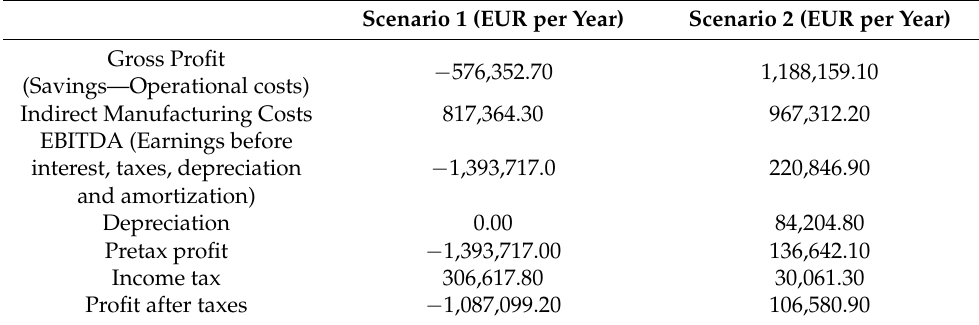
Table 8. Income data in Scenarios 1 and 2.